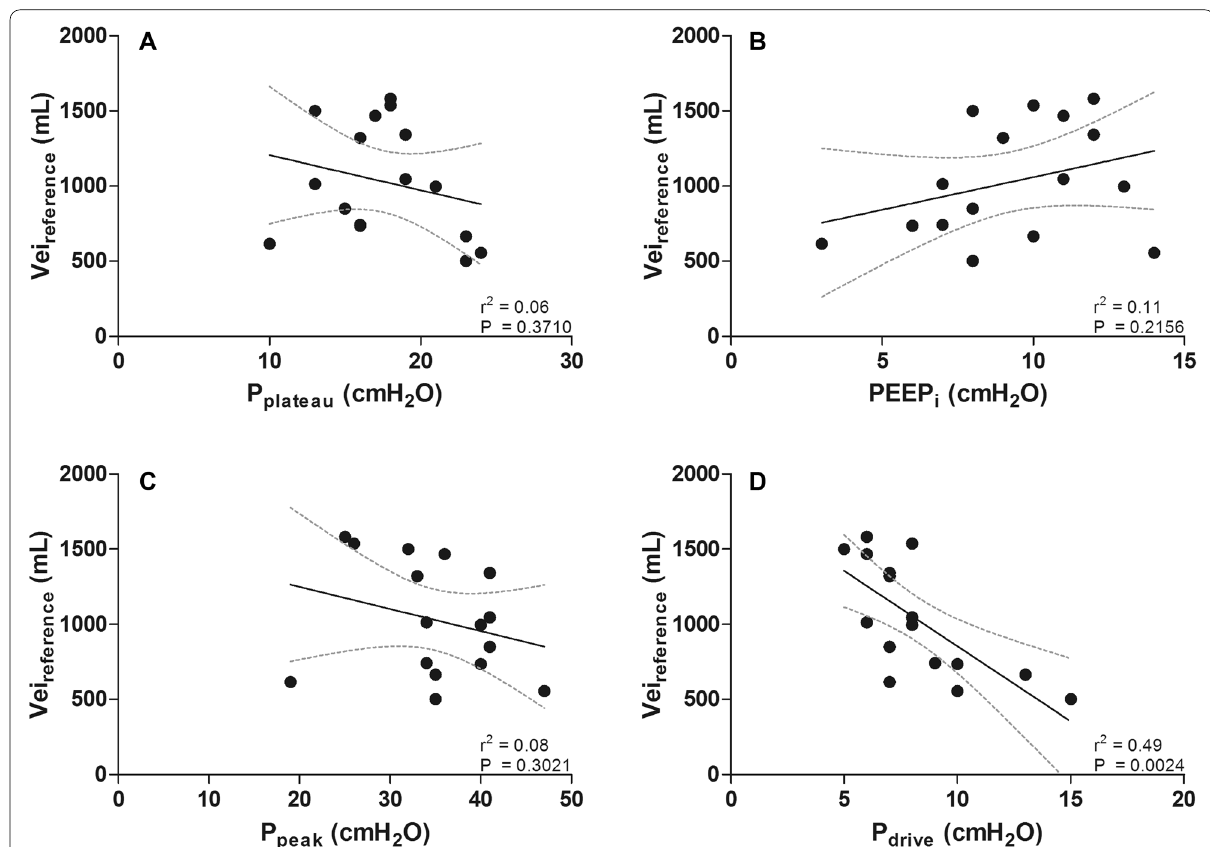
Fig. 2 Airway pressures are commonly used to quantify hyperinflation, especially P plateau and PEEP i . No correlation was found between P plateau and Vei reference ( A ) nor between PEEP i and Vei reference ( B ) or between P peak and Vei reference ( C ) (solid line with dashed 95% confidence interval (CI) lines). The driving pressure ( P